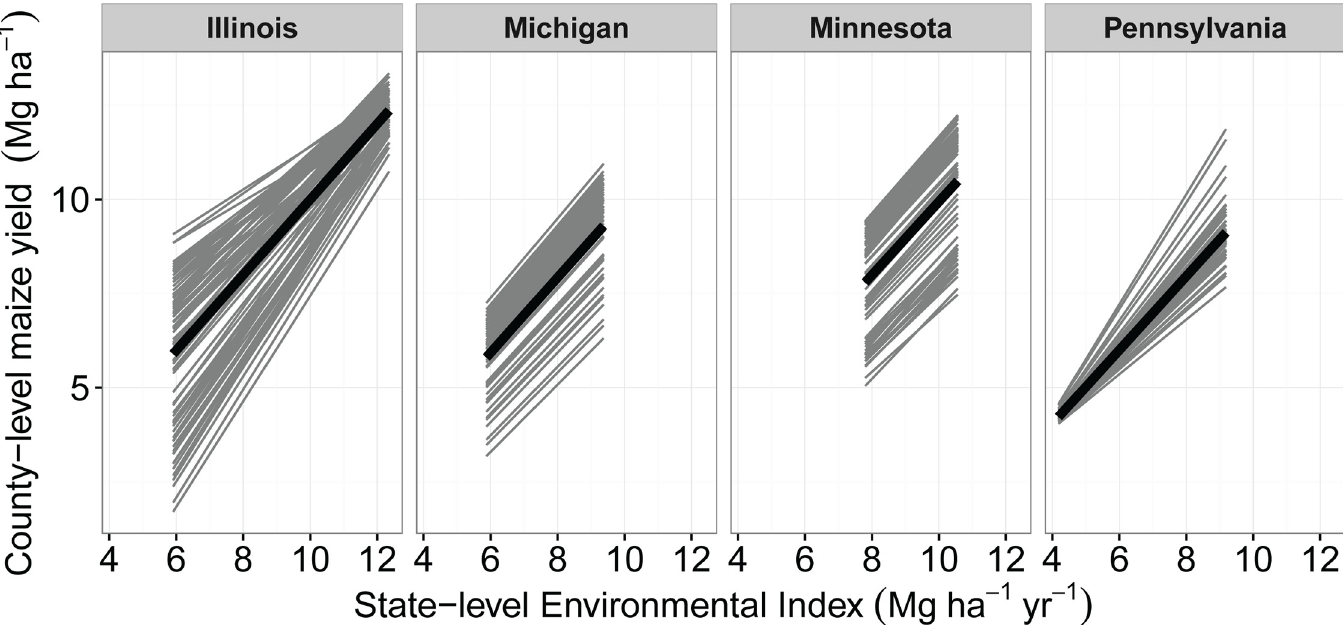
Fig 1. Linear mixed effects models of county-level maize yields (2000 – 2014) against statewide annual mean of maize grain yield (environmental index). Thick black lines show state mean fixed effect. Gray lines show individual county relationships (best linear unbiased predictors, BLUPs), as estimated from the random effects structure. Number of observations, by state: N IL = 1215, N MI = 705, N MN = 780, N PA =